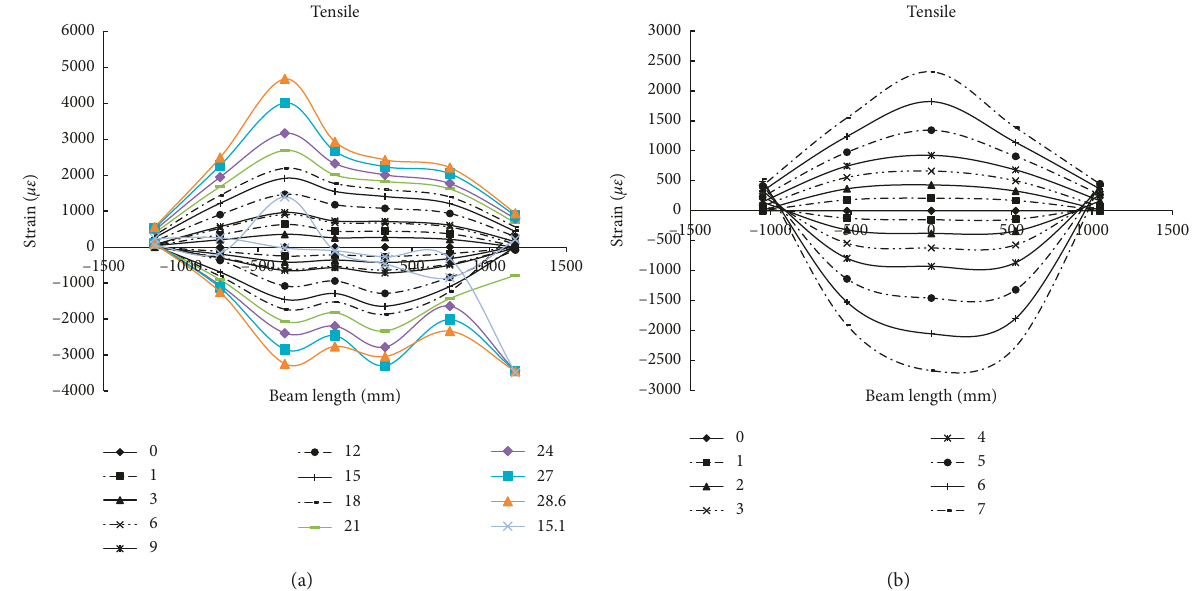
Figure 10: The distribution strain of aluminum alloy sheet and top of timber. (a) AU-T beam. (b) SU-OT beam (mm).